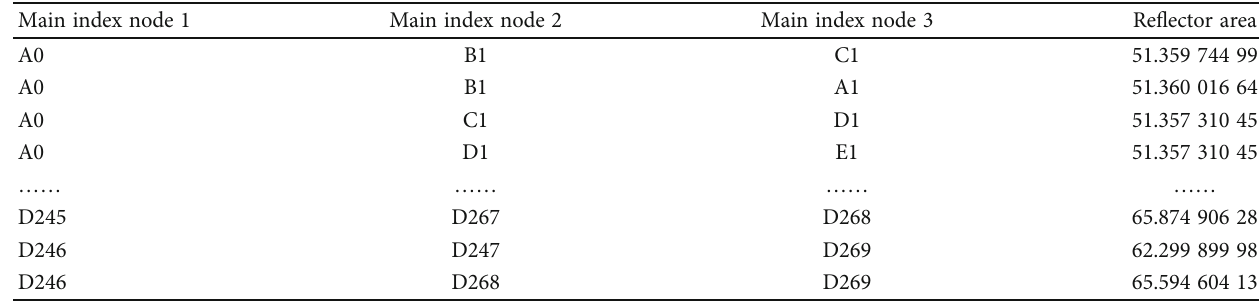
Figure 10: Distribution of electromagnetic wave reception ratio of parabolic re fl ector. Table 3: Area of each re fl ective panel participating in re fl ection within 300 m